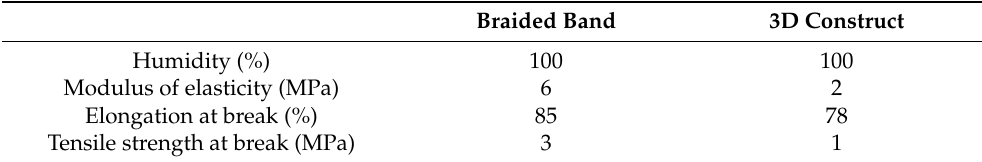
Table 1. Mechanical characterization of hyaluronate braided band and bioengineered 3D construct.